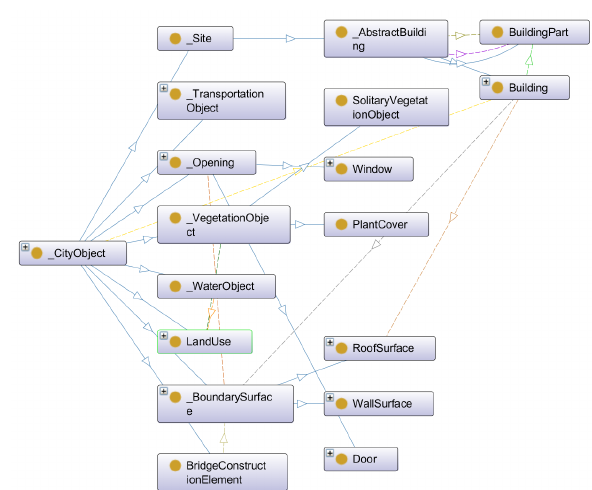
Figure 8. CityGML entities considered for the onto l ogy (OntoGraph viewer, Protègè).